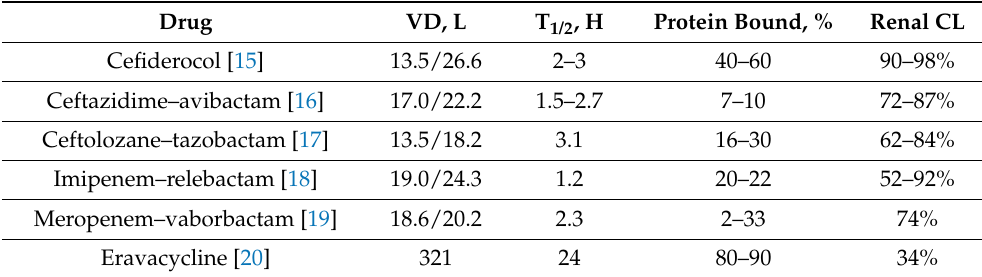
Table 2. Main pharmacokinetic properties of novel beta-lactam (BLs) and/or beta-lactams/beta- lactamases inhibitors (BL/BLIs) and